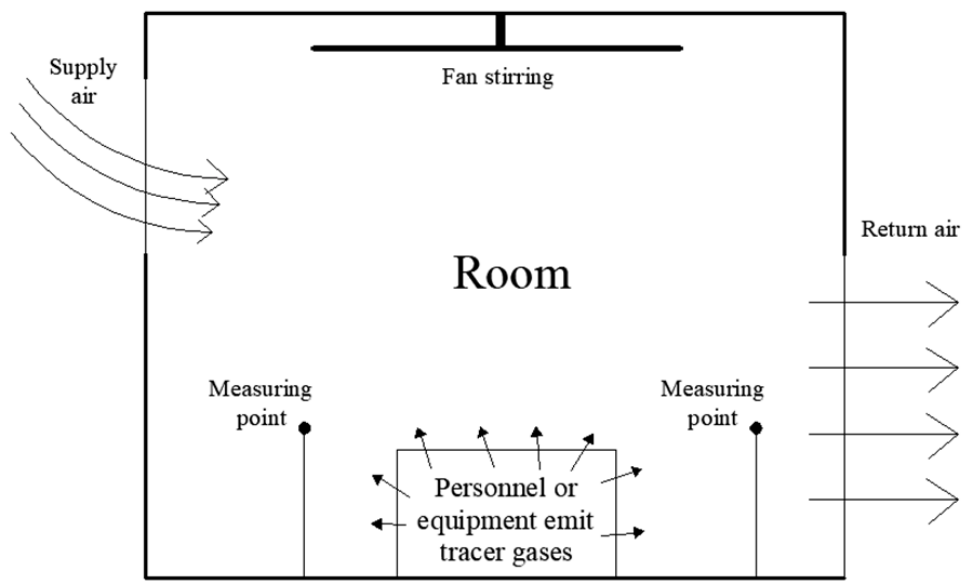
Figure 1. Schematic diagram of the tracer gas measurement room.